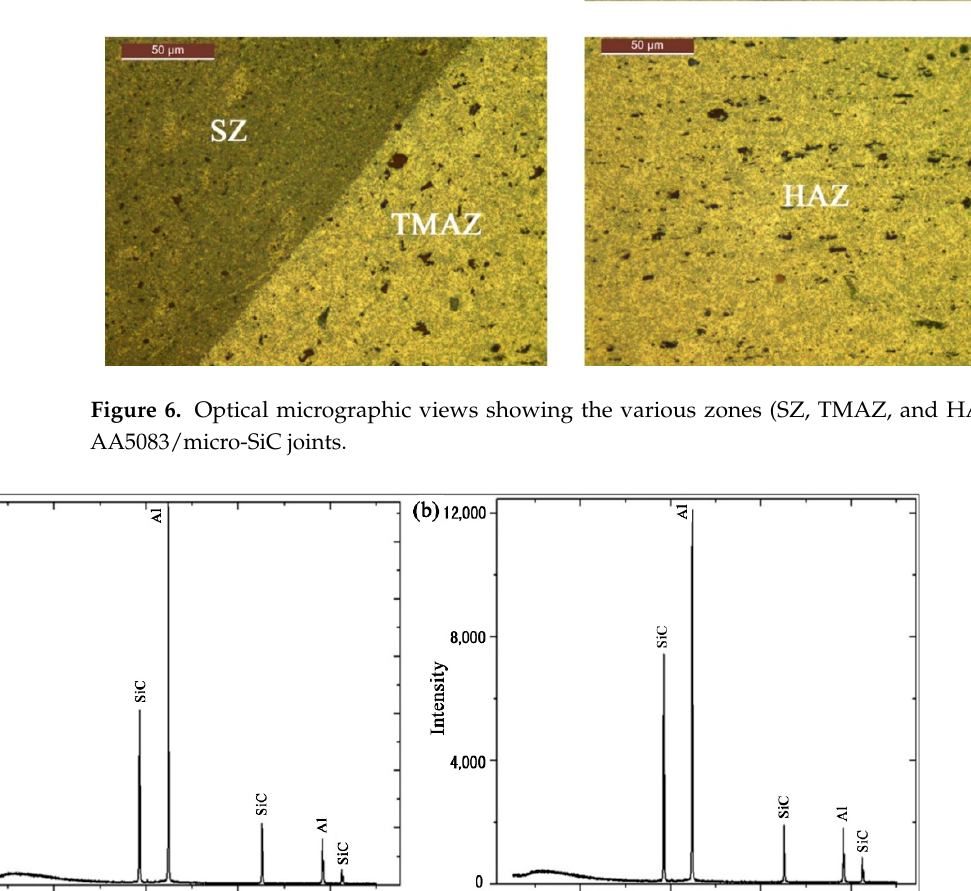
Figure 6. Optical micrographic views showing the various zones (SZ, TMAZ, and HAZ) of the AA5083/micro-SiC joints.